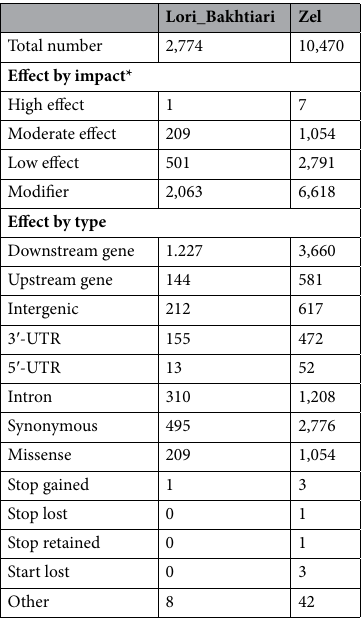
Table 2. Characteristics of the identified breed-specific SNPs in Lori-Bakhtiari and Zel breeds. * High effect the SNP is assumed to have disruptive impact in the protein, Moderate effect A non-disruptive SNP that might change protein effectiveness, Low effect assumed to be mostly harmless or unlikely to change protein behavior, Modifier usually non-coding SNPs or SNPs affecting non-coding genes.